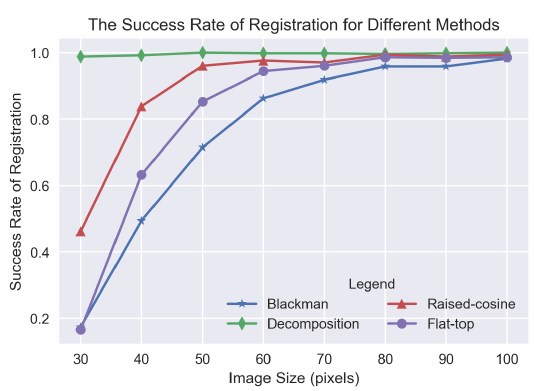
Figure 5. The success rate of registration for different